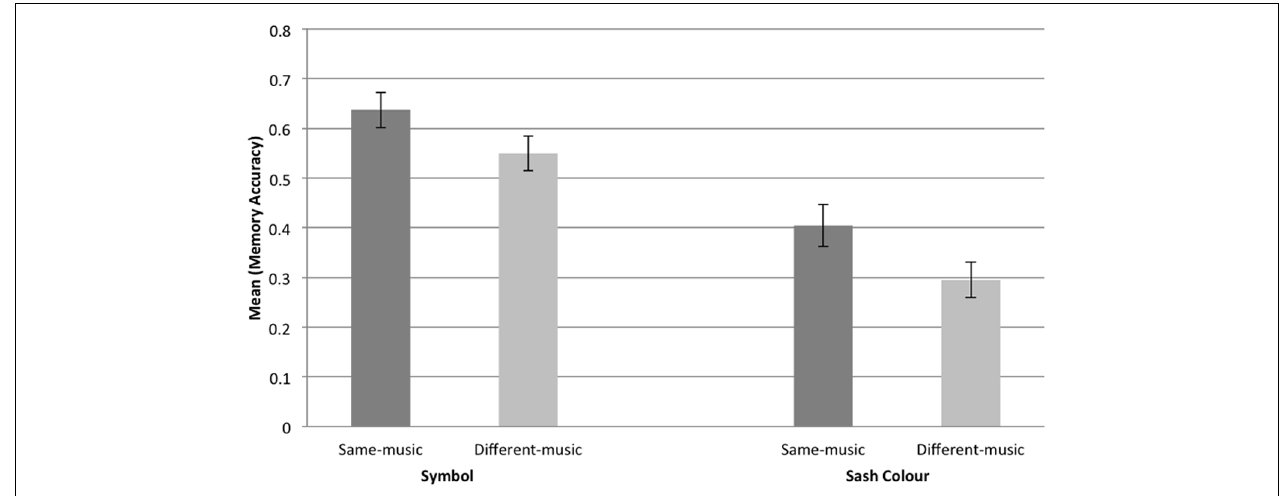
FIGURE 4 | Graph showing the mean response and standard error for symbol and sash color memory, same music, and different music.